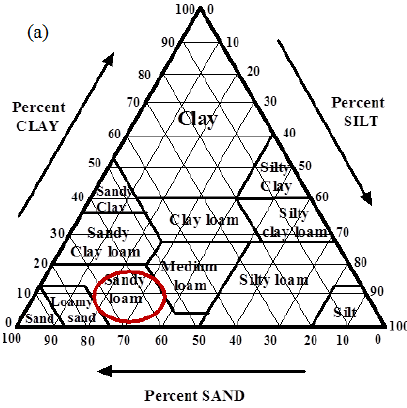
Figure A1. Soil texture from Sahel oil field (Abu Dhabi, UAE).